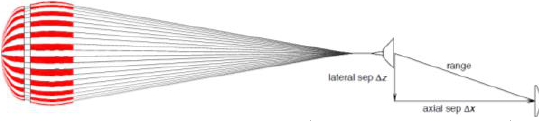
Figure 6.Heatshield separation (Taiszadeh et al., 2011)